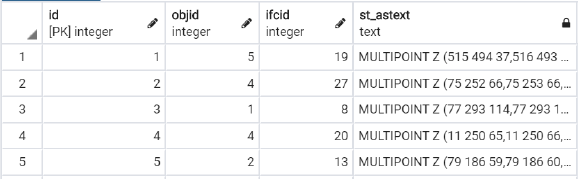
Figure 3. Example of a table created in PostgreSQL to store MULTIPOINT